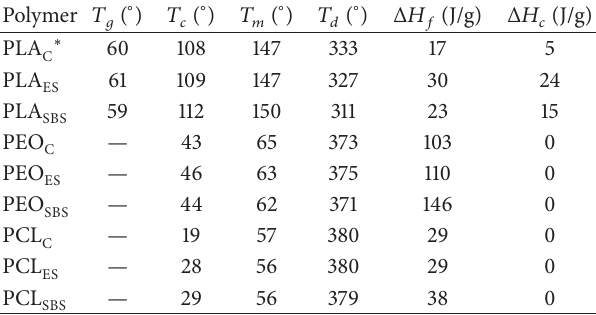
Table 6: Characteristic temperatures and heat of fusion ( Δ𝐻 𝑓 ) and crystallization ( Δ𝐻 𝑓 ) for PLA, PEO, and PCL films obtained by casting, SB-spinning, and